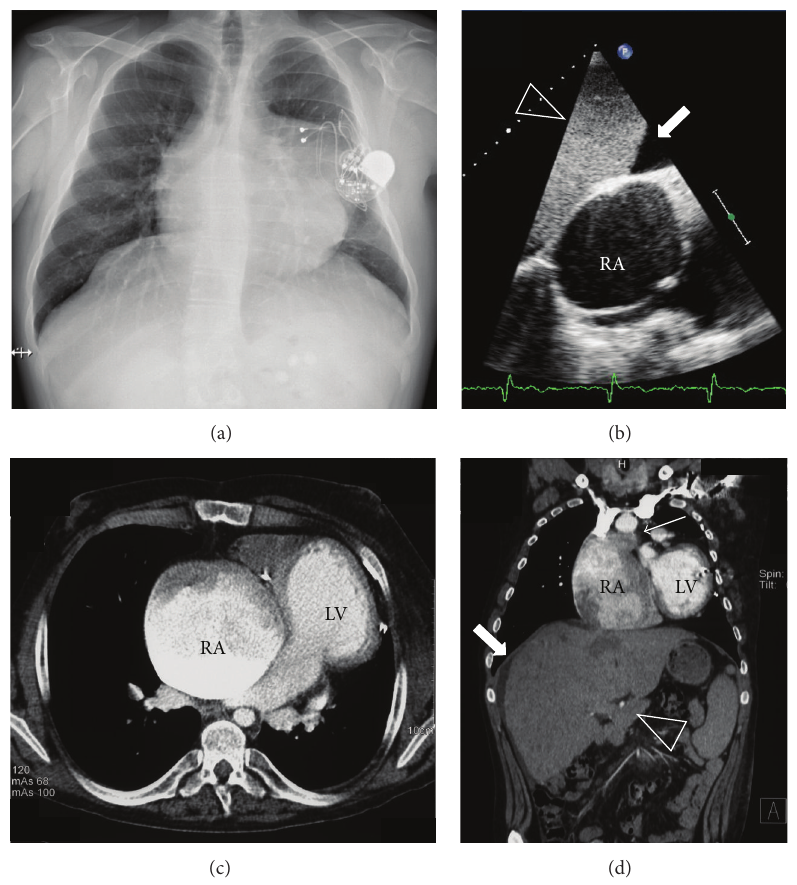
Figure 1: 31-year old patient with tricuspid atresia, atrial and ventricular septal defects, and severe infundibular pulmonary stenosis. He underwent surgical palliation with a Fontan procedure, initially using an atrial to right ventricular conduit, later converted to an atriopulmonary Fontan-Kreutzer-Anastomosis due to conduit failure. After increasing heart failure and 5 cardiac surgeries, he underwent heart transplantation. (a) Chest X-ray with massive cardiac enlargement and the epicardial pacemaker. (b) Subcostal echocardiographic view showing severely dilated right atrium (RA) with spontaneous echocontrast and perihepatic ascites (bold arrow). (c) Axial plane of chest-computed tomogram showing giant right atrium (RA) and normal-sized left ventricle (LV). (d) Coronal plane of chest and abdominal computed tomography showing enlarged right atrium (RA) with connection to the main pulmonary artery (arrow) and hepatomegaly (arrow